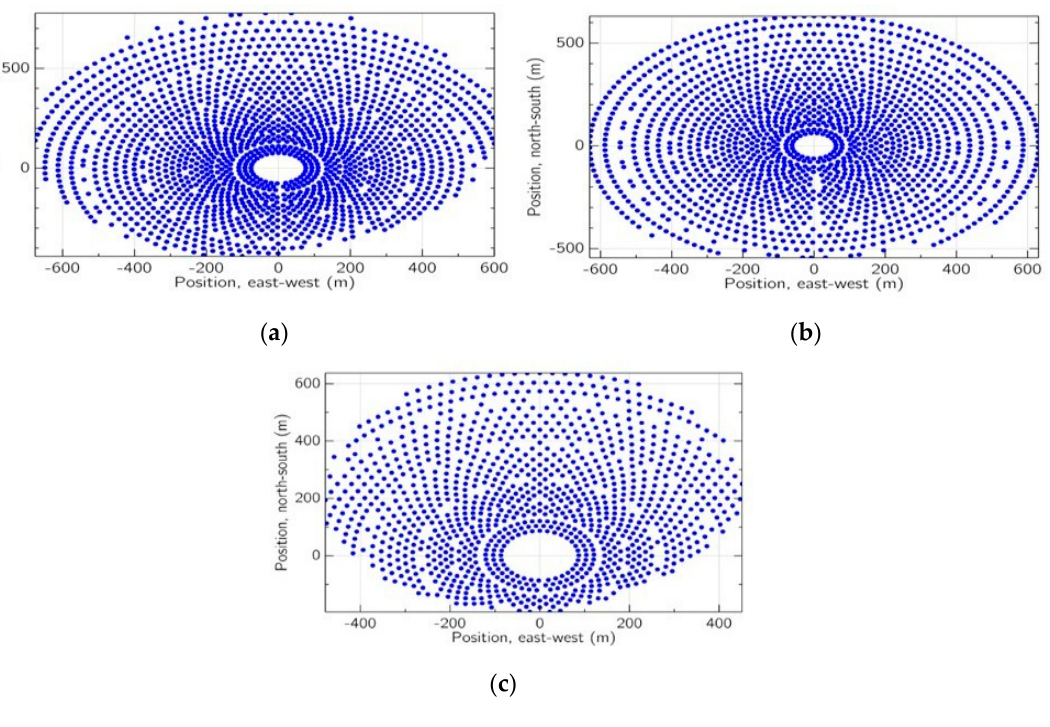
Figure 9. ( a ) Concentrated Solar Power (CSP) heliostats field configuration of Béchar region. ( b ) CSP heliostats field configuration of El Oued region. ( c ) CSP heliostats field configuration of Djelfa region.